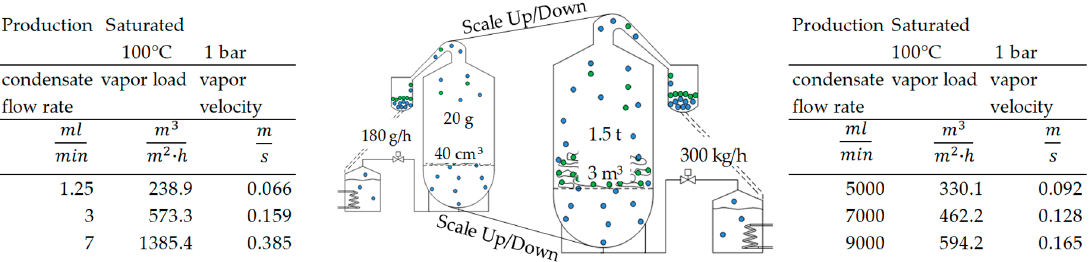
/ down of caraway distillation.